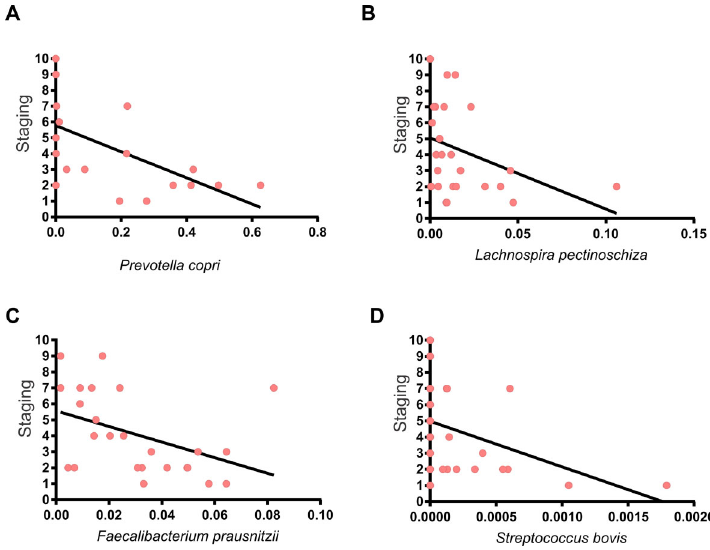
Figure 5. Spearman ’ s correlation between cancer staging and bacterial composition. Inverse correlation between cancer staging and A , Prevotella copri (Spearman R= – 0.5866 P=0.003); B , Lachnospira pectinoschiza (Spearman R= – 0.4222 P=0.041); C , Faecalibacterium prausnitzii (Spearman R= – 0.488 P=0.016); and D , Streptococcus bovis (Spearman R= – 0.482